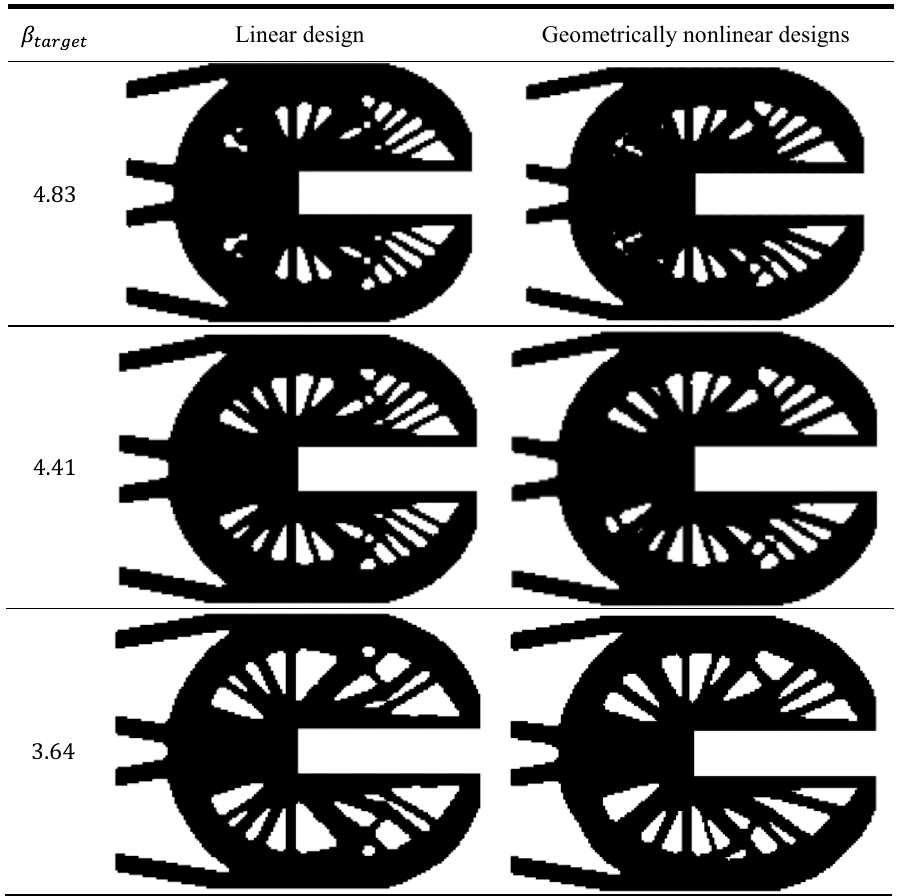
Table 6. Topological resulted shapes of the U-shaped plate in case of probabilistic